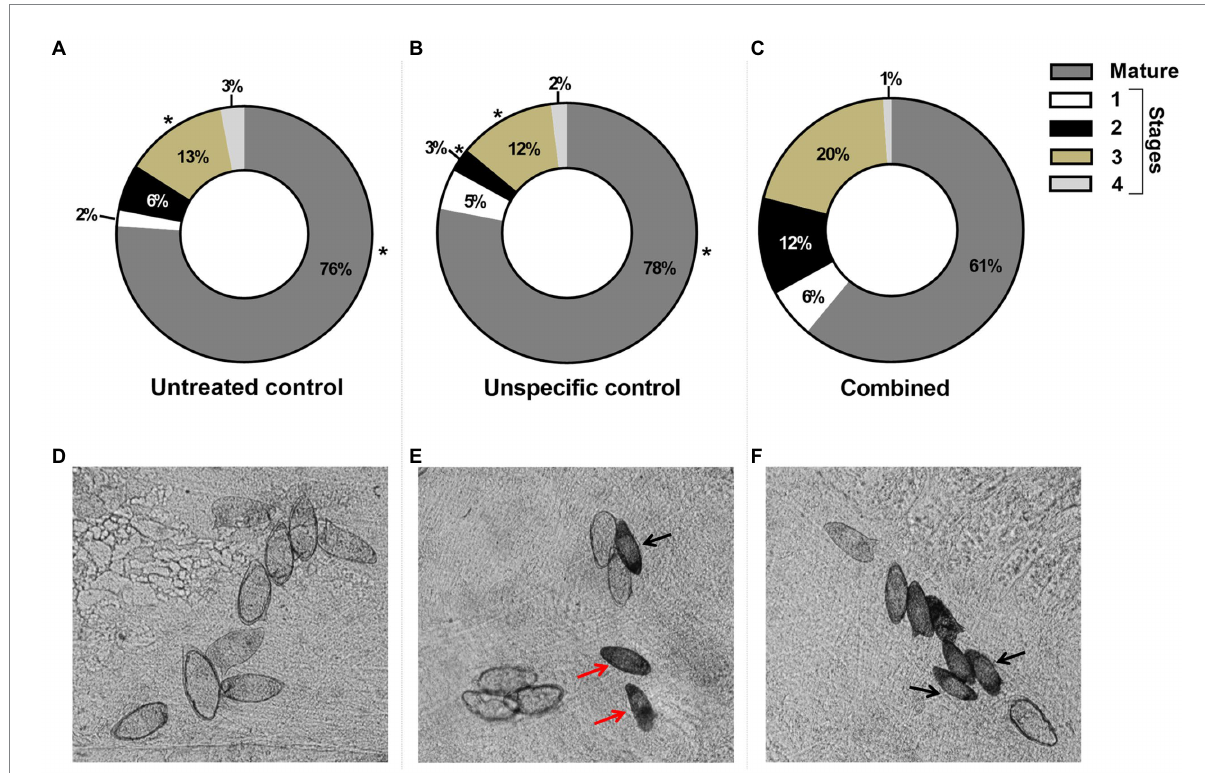
FIGURE 9 Egg maturation in the ileum of mice infected with schistosomula exposed to the dsRNAs of the five SmHGPRTases combined. The percentage of eggs in each maturation stage is represented in the circle section: mature (gray), stage 1 (white), stage 2 (black), stage 3 (beige), and stage 4 (light gray) for the untreated control group ( A ), GFP-dsRNA unspecific control ( B ), and the combined group ( C ). After verifying the normality using the Shapiro–Wilk test, significant differences compared to control conditions were analyzed by unpaired t -test (* p ≤ 0.05). ( D–E ) Representative images of the maturation pattern in each experimental group. Black arrow, eggs in stage 2; Red arrow, eggs in stage